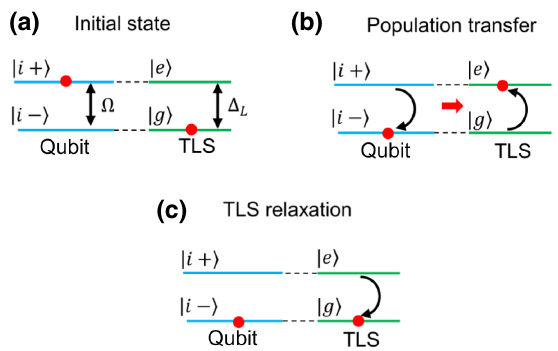
FIG. 7. Population transfer mechanism in the case of a “cold” TLS defect ( (cid:11) L > 0). Energy level diagrams in the rotating frame are shown at different stages of the population transfer process. (a) Qubit and defect are initialized to states | i +(cid:7) and | g (cid:7) , respectively. (b) Population is transferred from the qubit to the TLS defect. (c) TLS defect is reset to state | g (cid:7) by the defect energy relaxation